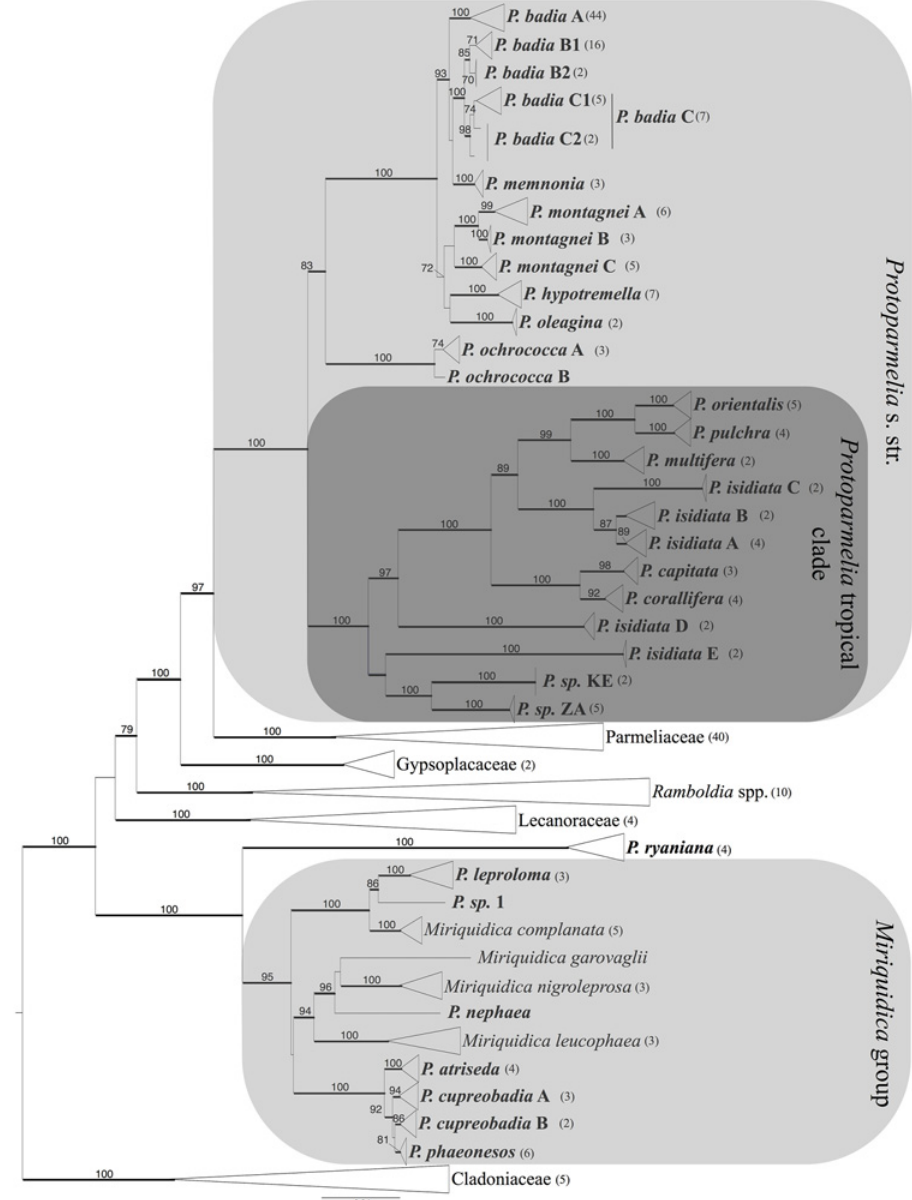
Fig 1. Phylogeny of Protoparmelia sensu lato and its allies based on a concatenated 6-locus data set including ITS, nuLSU, mtSSU, MCM7 , TSR1 and RPB1 sequences. This is a maximum likelihood tree. Numbers above branches indicate ML BS (cid:1) 70%. Branches in bold indicate Bayesian posterior probabilities (PP) (cid:1) 0.94. Terminal clades were collapsed for clarity of presentation. The length of the triangle corresponds to branch lengths. Numbers in parentheses indicate number of specimens included in collapsed clade. Identity of each specimen in a clade is given in Supporting information S1 Table. Protoparmelia s . l . species are in